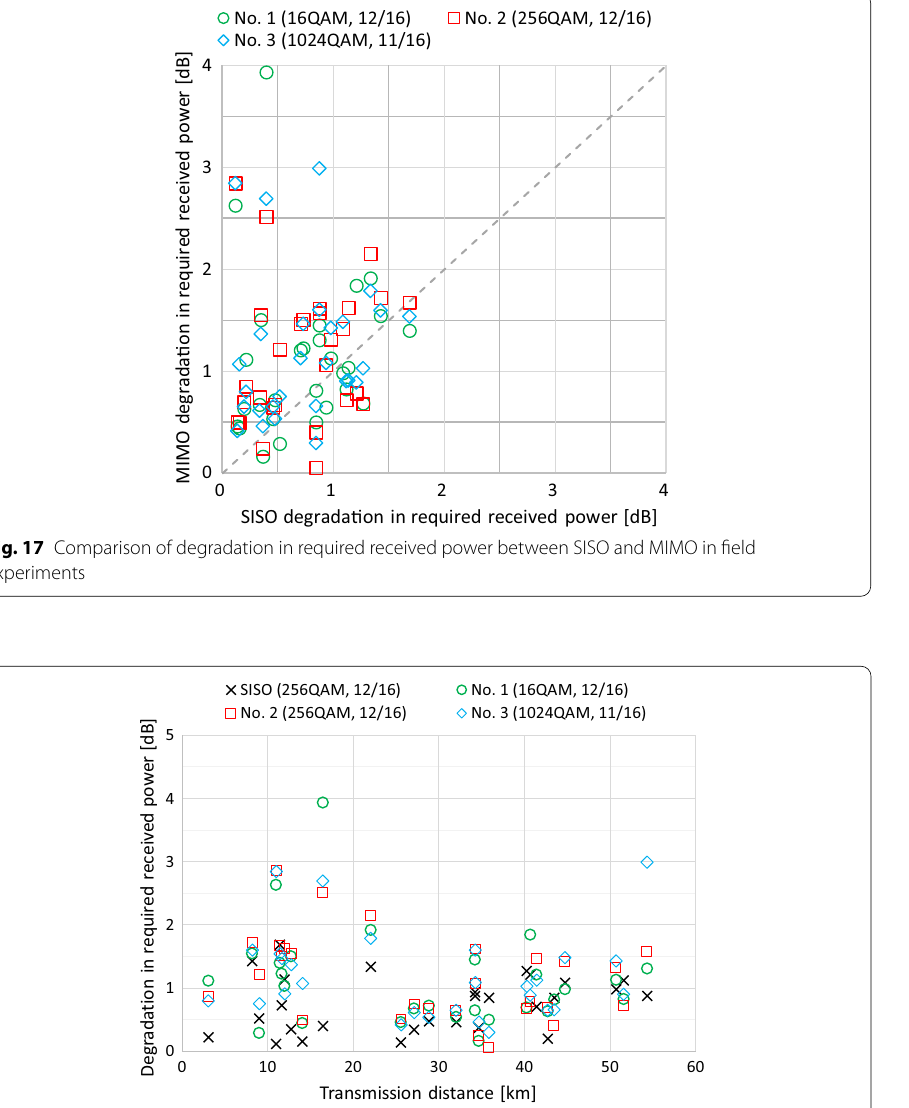
Fig. 18 Degradation in required received power from viewpoint of transmission distance in field